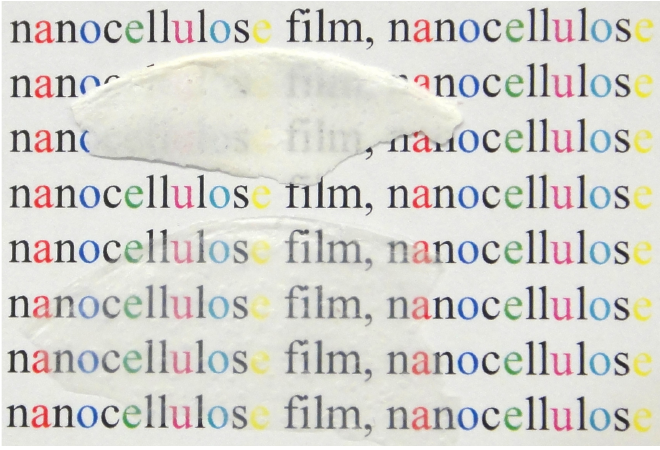
Figure 4. Cellulose films obtained from the pulp only treated with a colloidal mill (top, Figure 1C), and additionally treated with the high-pressure homogenizer (bottom, Figure 1D). Hydrogels obtained after sonication of the cellulose suspension did not form films upon